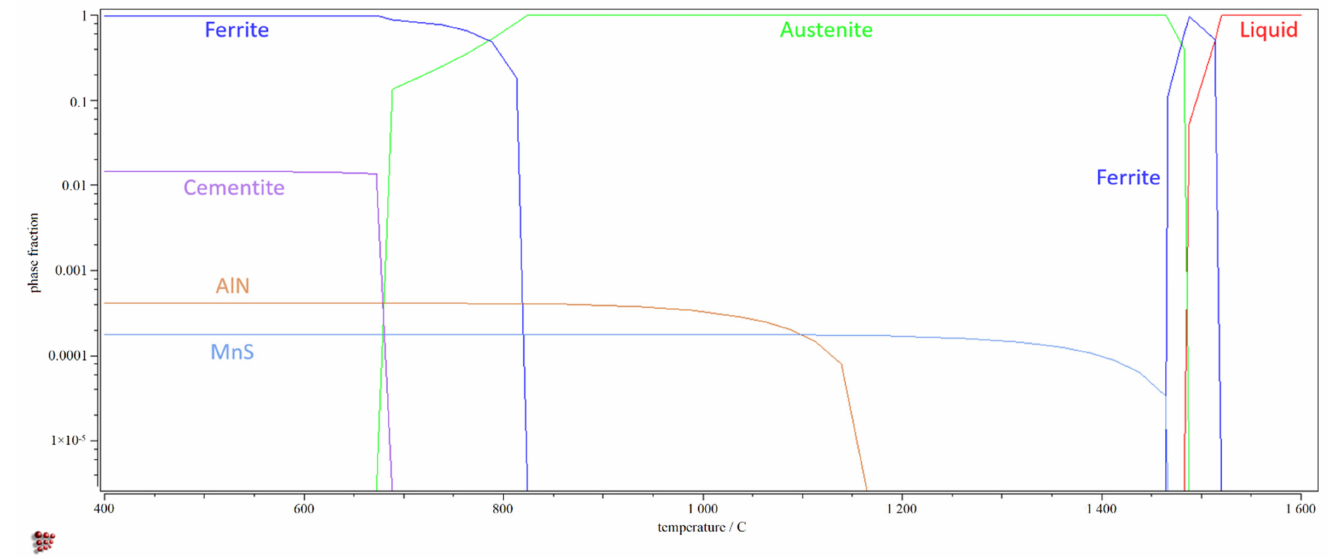
Figure 11. Phase diagram at equilibrium.